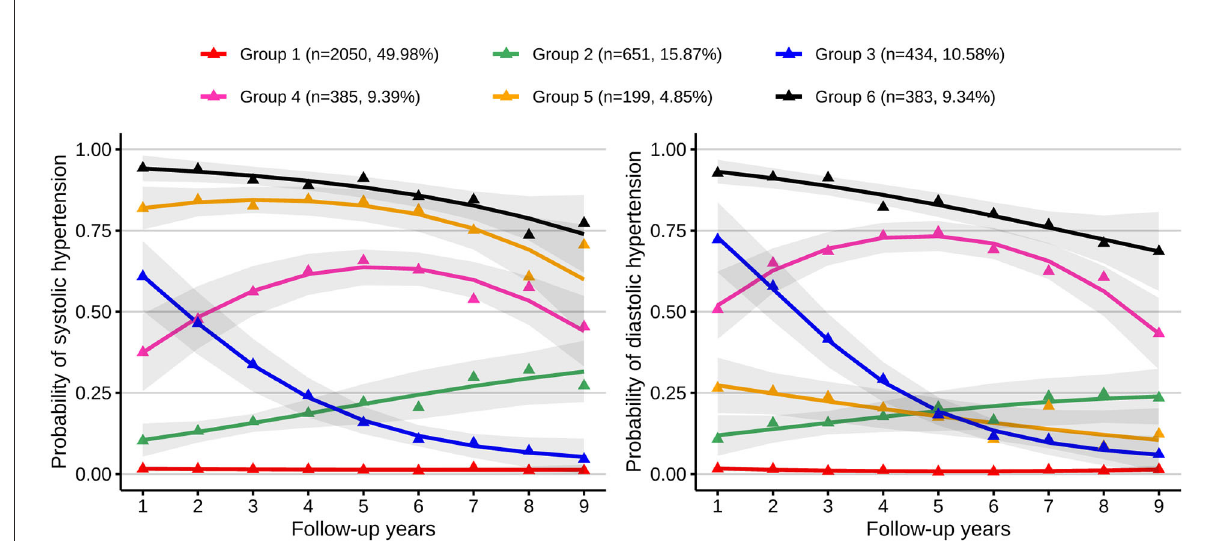
FIGURE1 Multi-trajectories of systolic and diastolic hypertension. Figure shows six multi-trajectories of systolic and diastolic hypertension which were identified from GBTM. Gray shadows represent the 95% confidence intervals for each trajectory; the solid lines represent expected trajectories; the points represent observed trajectories; numbers and proportions of group memberships are listed. Group 1 indicates the low-stable group; group 2, the low-increasing group; group 3, the medium-decreasing group; group 4, the medium-increasing-decreasing group; group 5, the isolated systolic hypertension phase group; group 6, the high-decreasing